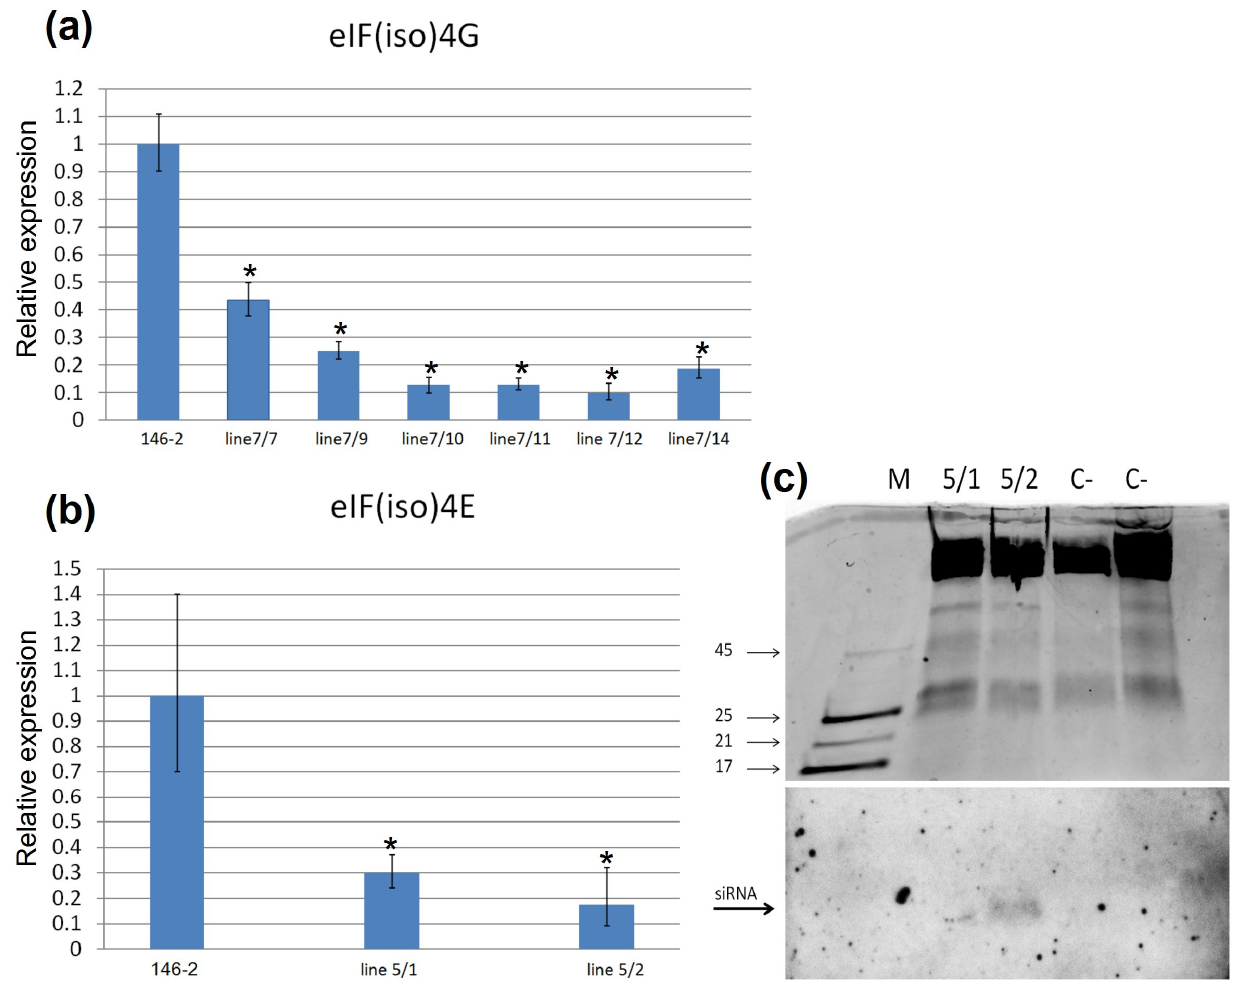
Figure 4. Relative expression of eIF(iso)4G and eIF(iso)4E genes and siRNAs analysis of rootstock plants carrying the hairpin construct. Reduction in the levels of eIF(iso)4G ( a ) and eIF(iso)4E ( b ) transcripts quantified by reverse transcription quantitative polymerase chain reaction (RT-qPCR). ( c ) Northern blot of transgene-derived siRNAs in transgenic rootstock lines 5/1 and 5/2. ( top ) The electropherogram of RNA preparations isolated from transgenic lines 5/1 and 5/2 and untransformed control (C − ) in 15% PAAG with 7M urea after staining with ethidium bromide; ( bottom ) the hybridization result of the probe to eIF(iso)4E gene. M—marker (17, 21, 25, and 45 nucleotides). * p ≤ 0.05 relative to control 146-2 in accordance with Kruskal–Wallis test.